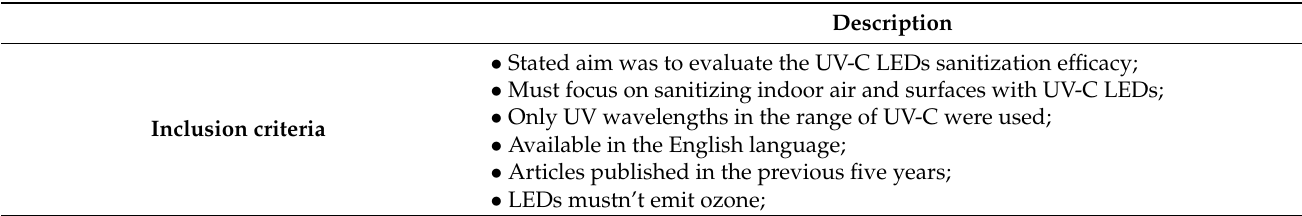
Table 2. Summary of the inclusion and exclusion